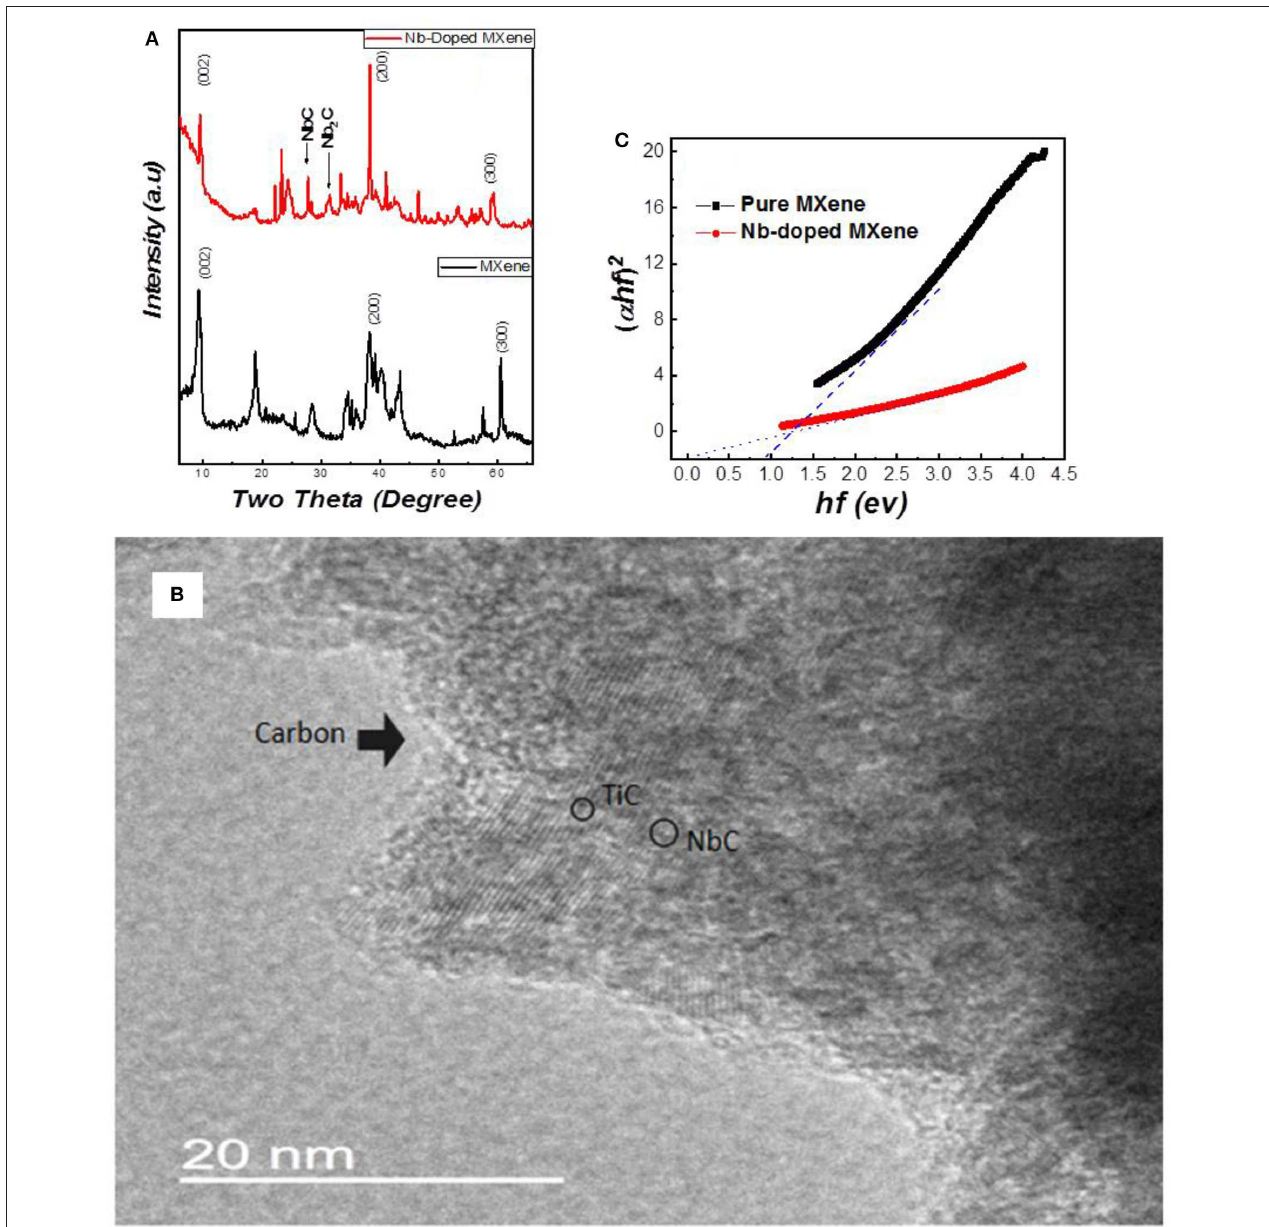
FIGURE 1 | (A) X-ray diffraction of undoped (black) and Nb-doped (red) Ti 3 C 2 MXene. (B) Transmission electron microscopy image of Nb-doped MXene. (C) Comparison of the bandgaps for undoped (black) and Nb-doped (red) Ti 3 C 2 MXene.